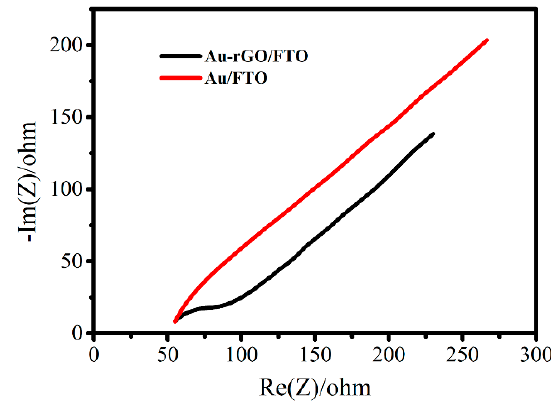
Figure 4. EIS of 3D Au-rGO/FTO (black line) and Au/FTO (red line) in 5 mM K 3 Fe(CN) 6 .